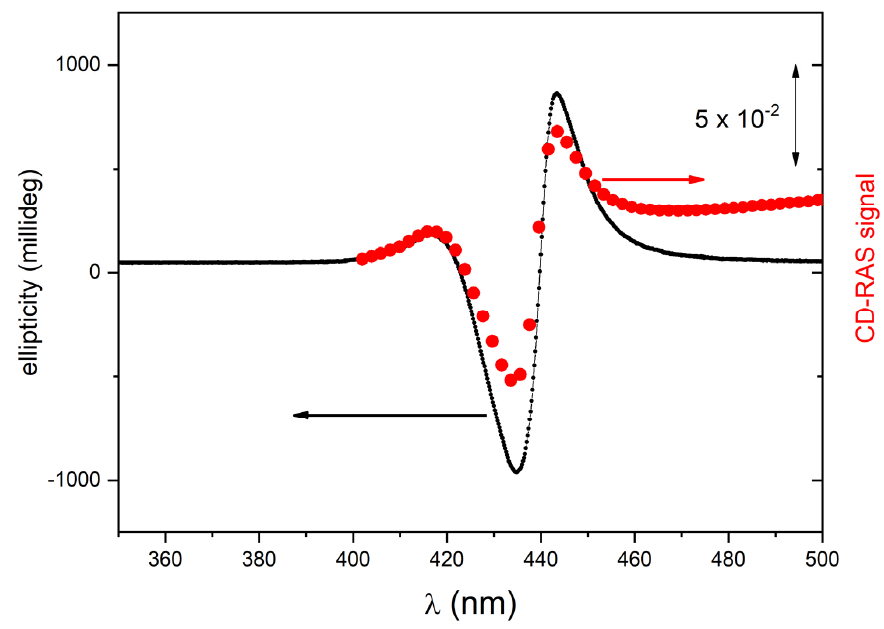
Figure 4. CD-RAS experimental spectrum for sample A1 (red curve, right vertical axis), compared with the ellipticity spectrum measured for the same sample by a commercial spectrometer for circular dichroism (black curve, left vertical axis). The CD-RAS spectrum is reported as measured, without correction. The double-arrow reported in the figure is the unit for the CD-RAS data. Here, sample A1 is a solution containing II-type aggregates of ZnP(L)Pro(–) in hydroalcoholic solution (EtOH:water 25:75, 5 μ M).